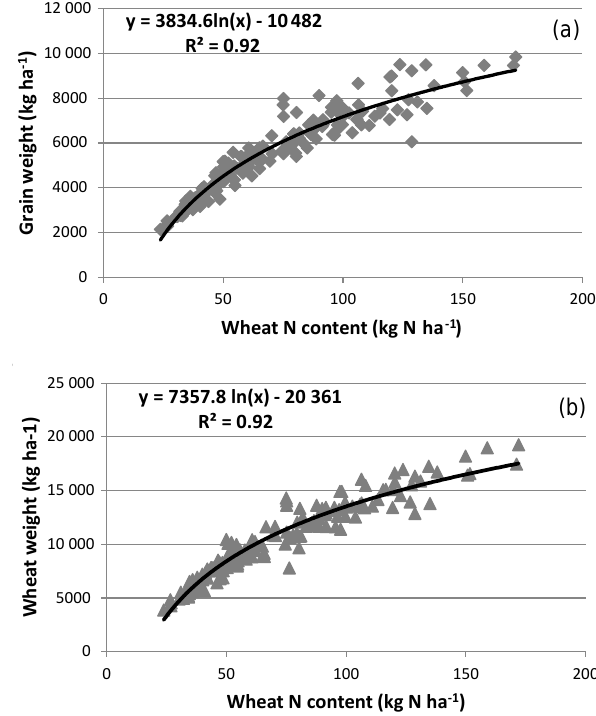
Figure 5. Effect of N applied in a previous melon crop on (a) grain weight and wheat N content; (b) wheat weight and wheat N content; and (c) grain weight and grain N content.